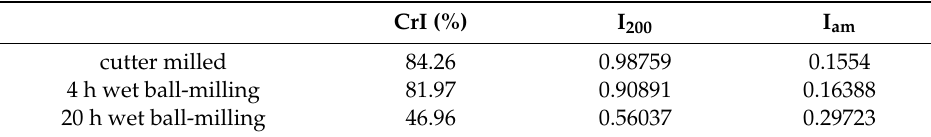
Figure 2. X-ray di ff raction (XRD) pattern of ( a ) hemp particles and ( b ) composite films. Figure 2. X-ray diffraction (XRD) pattern of ( a ) hemp particles and ( b ) composite films. Table 1. CrI of hemp particles after di ff erent